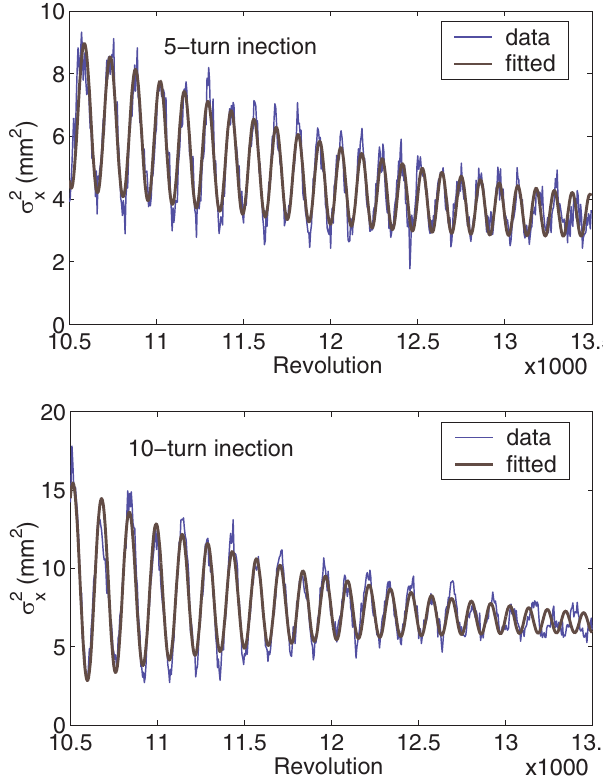
FIG. 21. (Color) Top: Fit (cid:2) 2 injection. Bottom: Fit (cid:2) 2